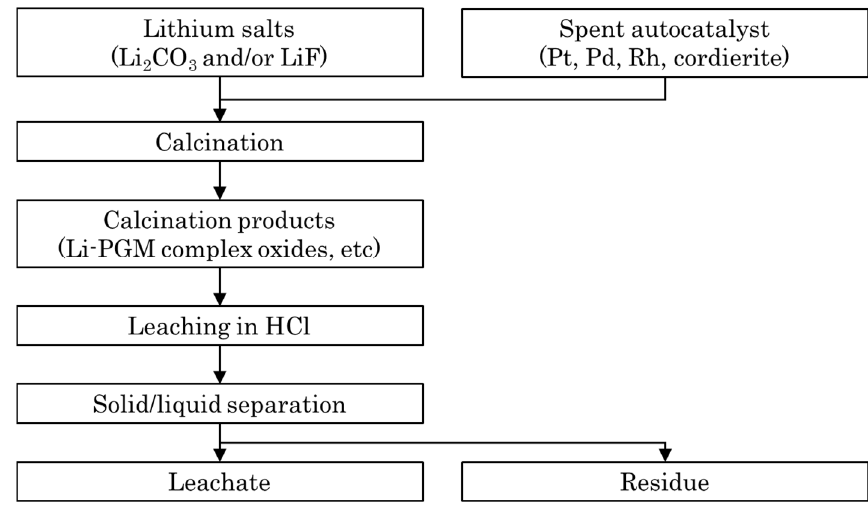
Figure 1. Flowchart of the platinum group metal (PGM) leaching process using Li salts.